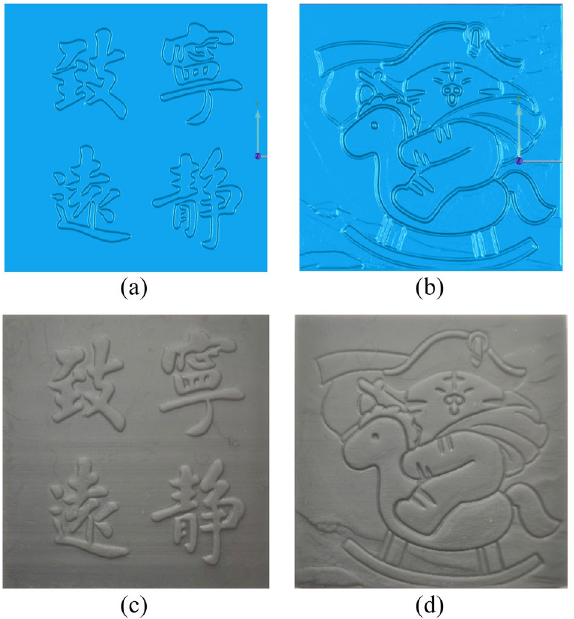
Figure 17. Image 3D reconstruction and 3D printing results: ( a ) the 3D reconstruction of simple calligraphy images; ( b ) the 3D reconstruction of complex cartoon images; ( c ) the 3D printing picture of simple calligraphy images; ( d ) the 3D printing picture of complex cartoon